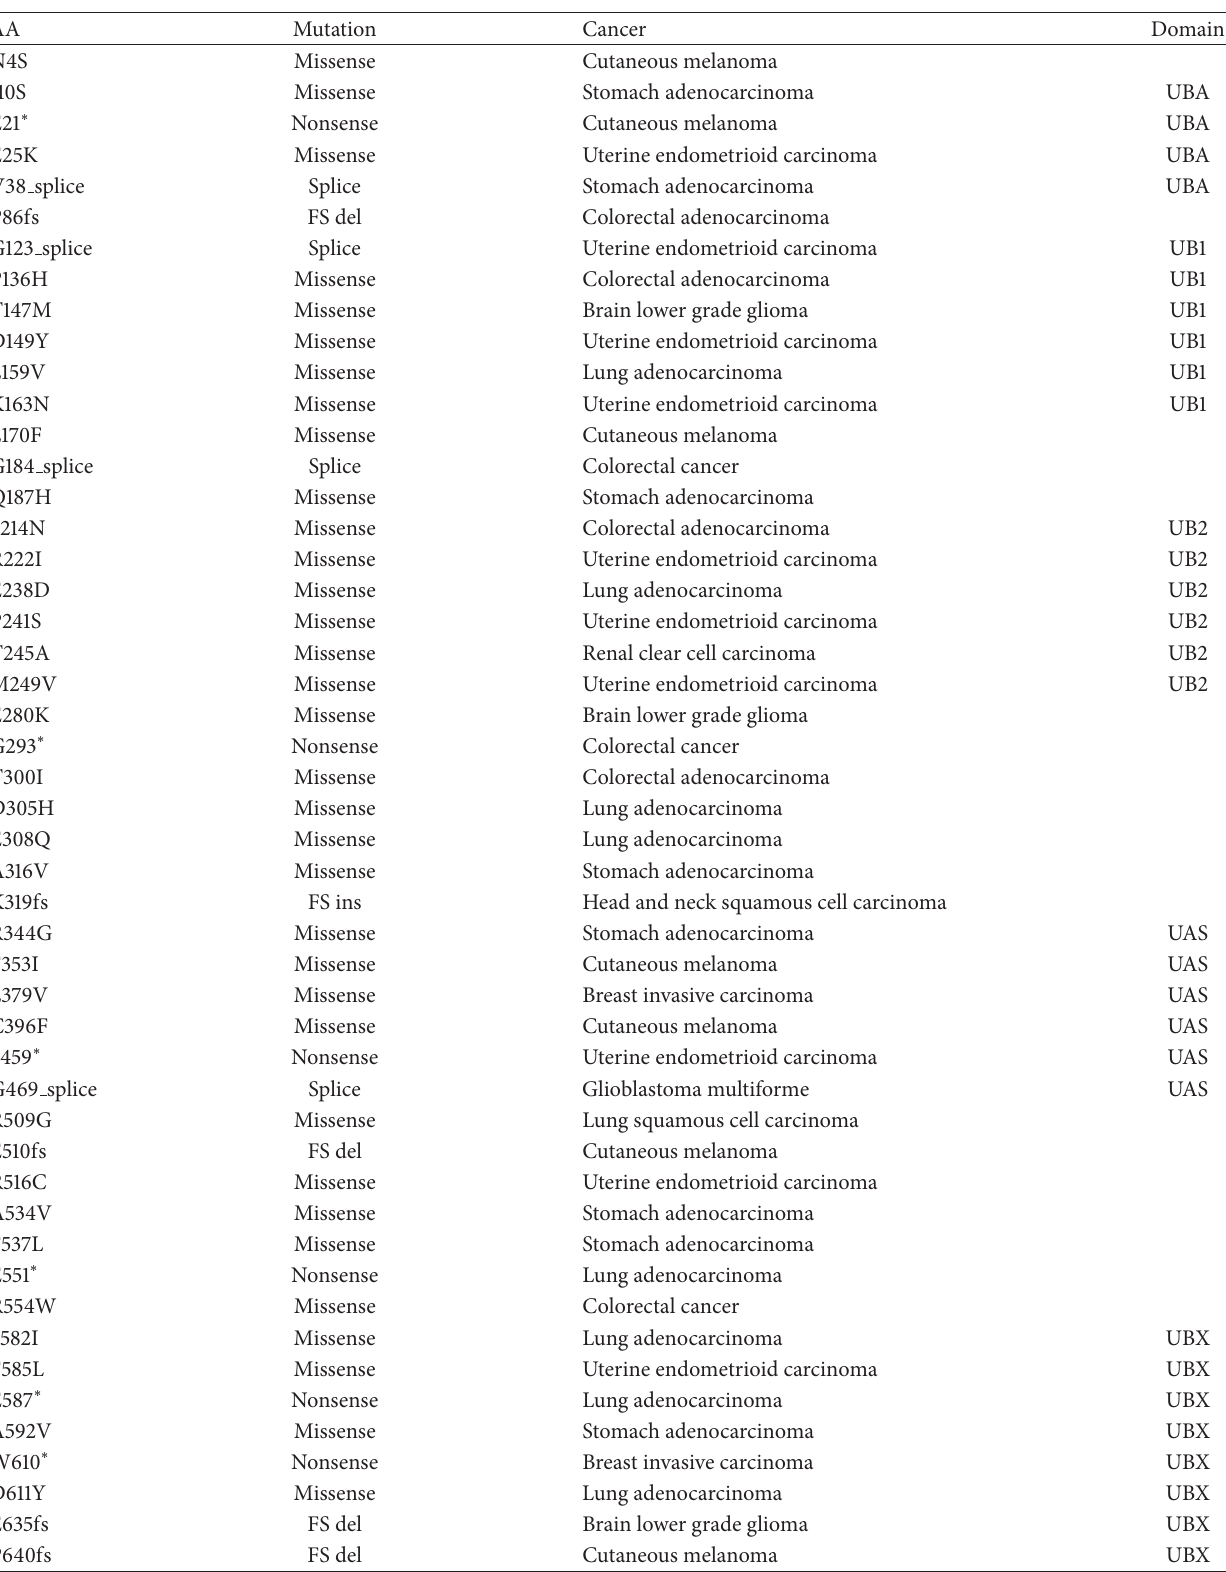
Table 4: FAF1 mutations in various cancers. FAF1 mutations listed in the TCGA data base were identified without restriction to any type of cancer. For the location of the affected domains on the protein compare Figure